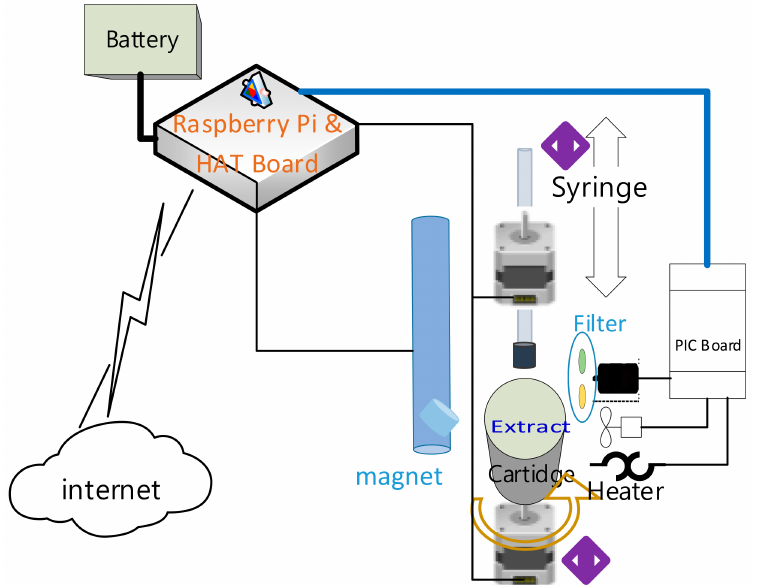
Figure 2. DNA extraction system configuration diagram. The PIC microcontroller (PIC) Board is connected to the Hardware Attached on Top (HAT)